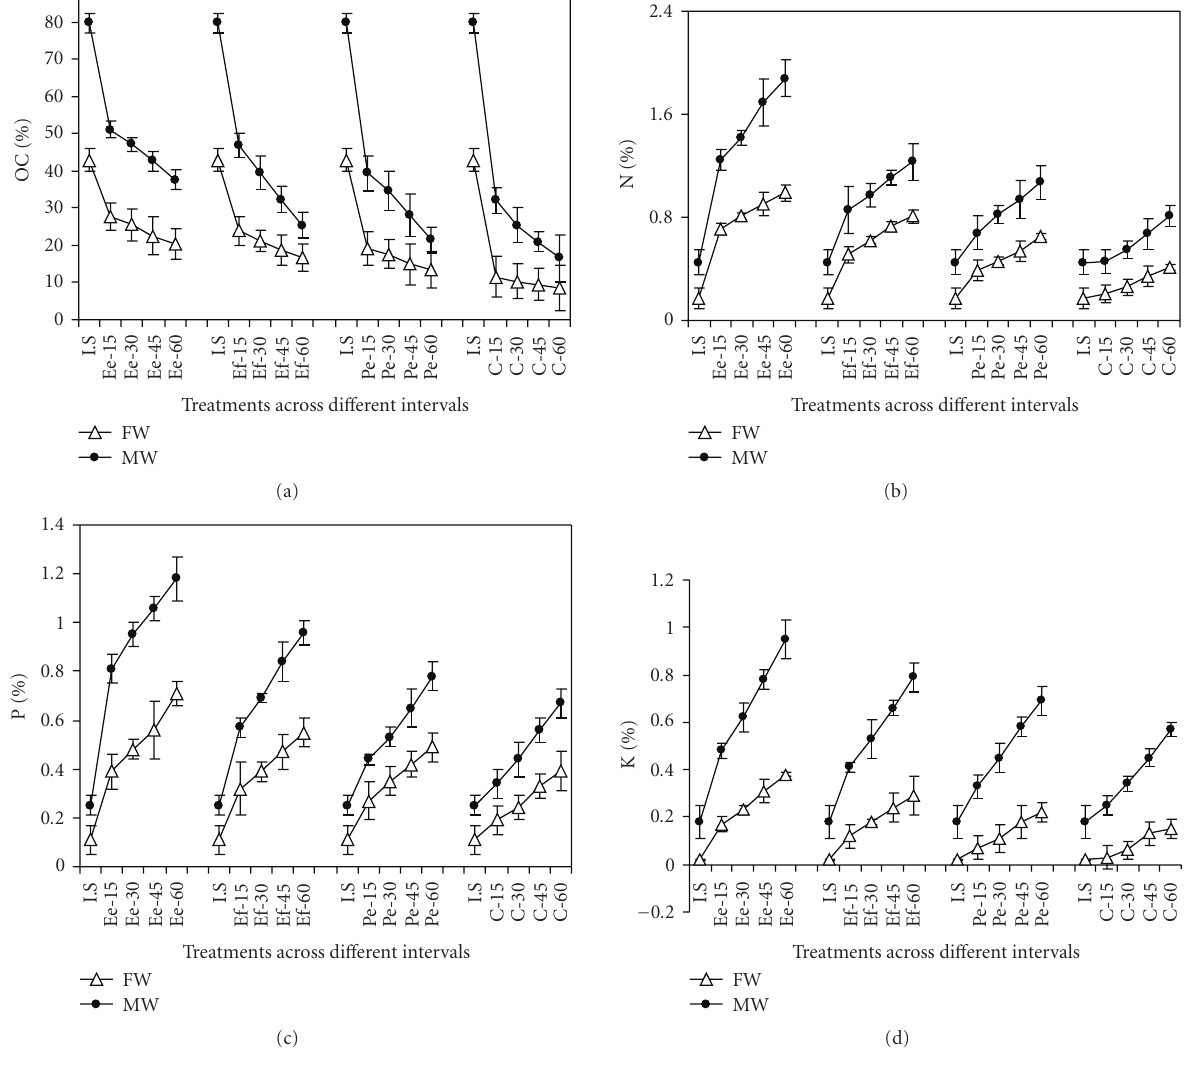
Figure 1: Major nutrients—OC, N, P, K (%) of vermicompost (VC) of three di ff erent species of earthworms— Eudrilus eugeniae (Ee) at 15 days (Ee-15), 30 days (Ee-30), 45 days (Ee-45), and 60 days (Ee-60); Eisenia fetida (Ef) at 15 days (Ef-15), 30 days (Ef-30), 45 days (Ef-45), and 60 days (Ef-60); Perionyx excavatus (Pe) at 15 days (Pe-15), 30 days (Pe-30), 45 days (Pe-45), and 60 days (Pe-60); and Compost (C) at 15 days (C-15), 30 days (C-30), 45 days (C-45), and 60 days (C-60) produced from FW and MW. (a) OC, (b) N, (c) P, (d)